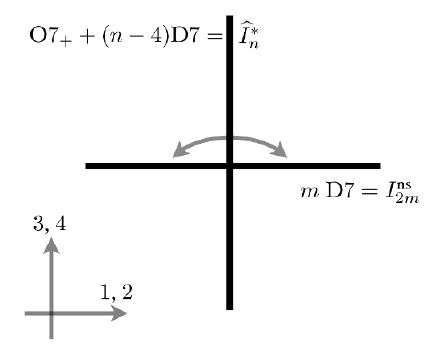
Figure 2 . An O7-D7 intersection, interpreted in F-theory as an intersection between an an I ns 2 m